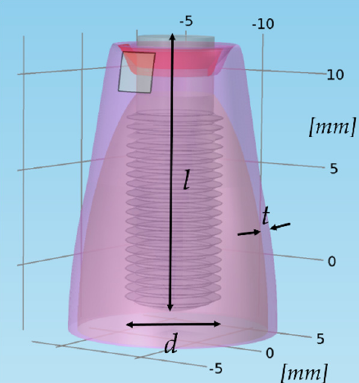
Figure 7. Model geometry of the dental implant screwed in the jawbone: d is the implant diameter (4 mm), l is its length (14 mm), and t is the gingiva thickness (1 mm); the red portion of the gingiva, near the implant, is the inflamed one. Table 1. Biological tissue electric properties at 312.5 kHz (i.e., therapeutic signal